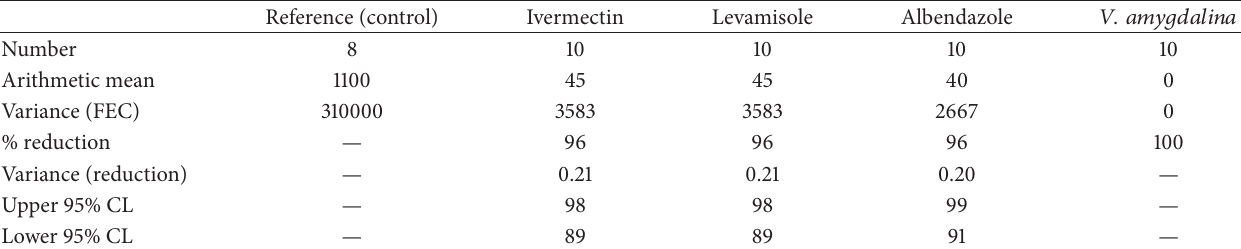
Table 1: Faecal egg count